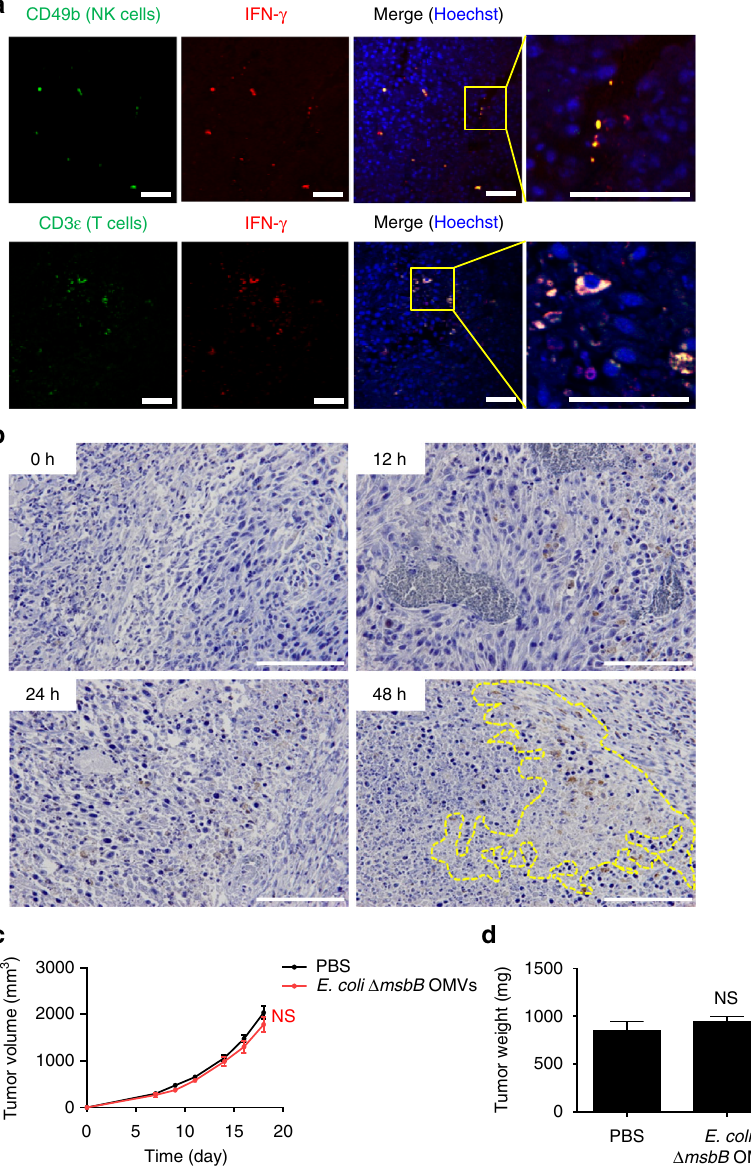
Fig. 5 Importance of NK and T cells on OMV antitumor effect. a Images of tumor tissues isolated from wild-type mice bearing CT26 tumors, stained for IFN- γ , and NK cells ( top ) or T cells ( bottom ) 48 h after intravenous injections of E. coli Δ msbB OMVs. The cell nucleus is stained in blue (Hoechst), whereas NK and T cells are shown by green fl uorescence signal and IFN- γ is shown in red fl uorescence signal, respectively. Scale bars , 50 μ m. b Images of tumor tissues isolated from wild-type mice bearing CT26 tumors, stained for NK cells (brown spots) at different time points after intravenous injections of E. coli Δ msbB OMVs. Tumor necrotic area around NK cells at 48 h is shown in dashed lines. Scale bars , 50 μ m. c , d Tumor volume of NIHS-Lyst bg Foxn1 nu Btk xid mice bearing CT26 tumor measured after E. coli Δ msbB OMV treatments c and tumor weight at the end of the experiment d . Data are presented as the mean ± SD ( n = 6 mice per group). NS indicates not signi fi cant analysed by two-way ANOVA c and unpaired Student ’ s t -test